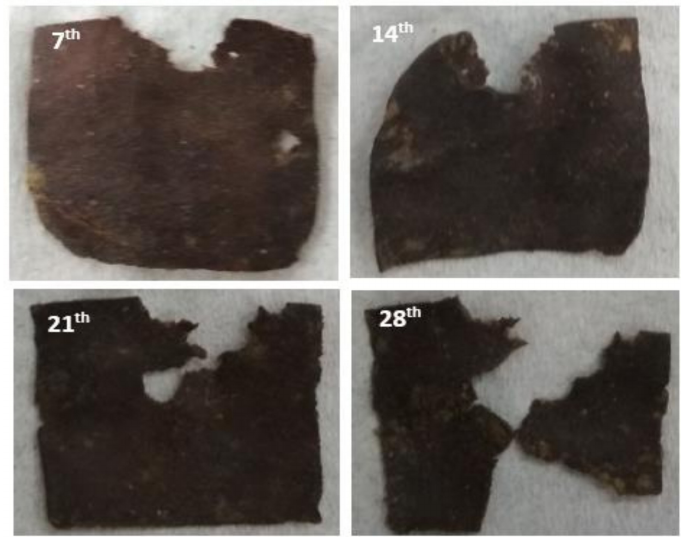
Figure 4. Physical appearance of biofilm 5% of CEO at the 7th , 14th , 21th , and 28th